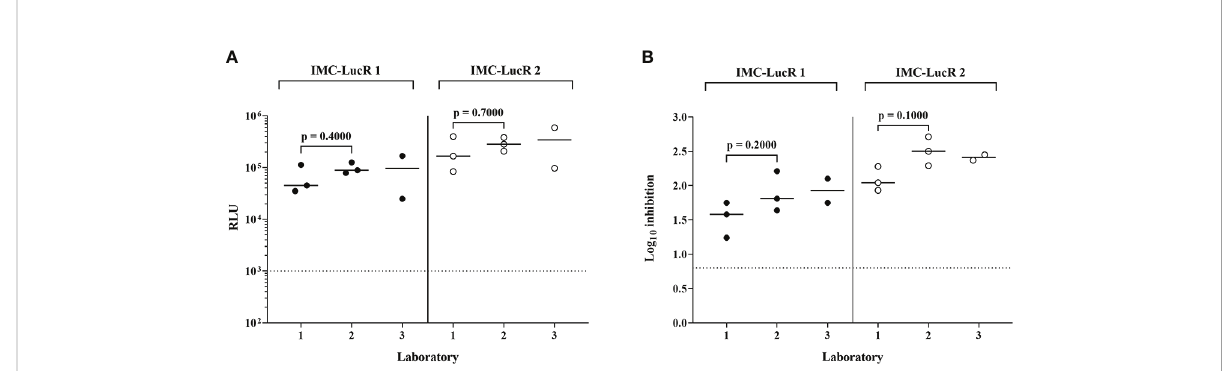
FIGURE 6 Performance of positive control CD4 and CD8 T-cell lines in the IMC-LucR VIA across 3 laboratories. (A) Replication of IMC-LucR in CD4 T-cell line measured by RLU and (B) Inhibition of IMC-LucR replication mediated by an autologous CD8 T-cell line measured by log 10 reduction in RLU of CD4 and CD8 T-cell line co-cultures compared with infected CD4 T-cell line alone. Bars represent median values. Triplicate data for laboratories 1 and 2 were analysed using a Mann-Whitney test. The dotted line represents the assay positivity value (>0.8